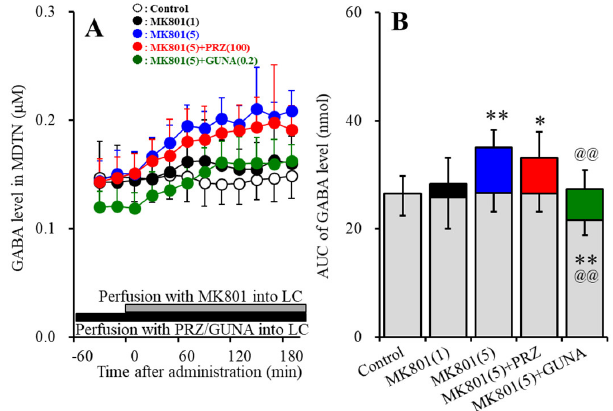
Figure 4. Effects of local administration of PRZ and GUNA into the LC on MK801-induced GABA release in the mediodorsal thalamic nucleus (MDTN). Ordinate: mean ± SD (n = 6) of extracellular GABA level (μM); abscissa: time after MK801 administration (min). Black bars indicate perfusion with 100 μM PRZ or 0.2 μM GUNA into the LC. Gray bars indicate perfusion with 1 μM and 5 μM MK801 into the LC. ( B ) indicates the AUC values of extracellular GABA level (nmol) after perfusion with MK801 (from 20 to 180 min), based on ( A ). Gray columns represent the AUC values before perfusion with MK801 (basal release). * p < 0.05, ** p < 0.01; relative to control, @@ p < 0.01; relative to MK801 (5 µ M) by MANOVA with Tukey’s post hoc